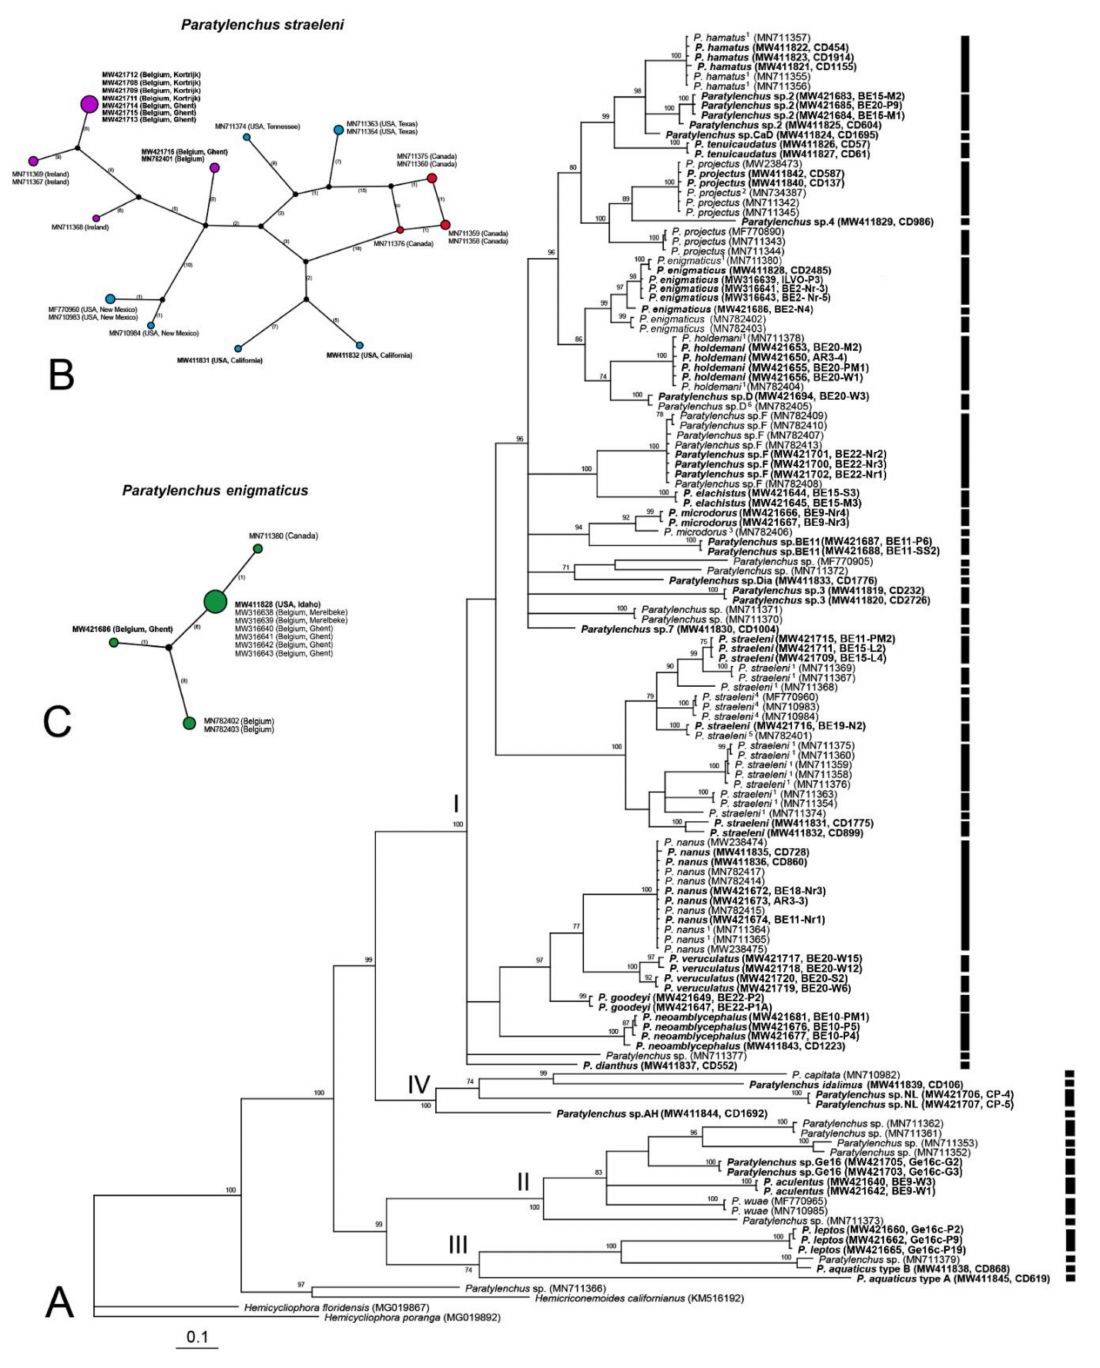
Figure 19. ( A ). Phylogenetic relationships within populations and species of Paratylenchus , as inferred from Bayesian analysis using the COI gene sequence dataset with the GTR + I + G model. Posterior probability more than 70% is given for appropriate clades. Newly obtained sequences are indicated in bold. 1 = originally identified as Paratylenchus sp., 2 = originally identified as P. nanus , 3 = identified as Paratylenchus sp.E, 4 = originally identified as Gracilacus sp., 5 = originally identified as Paratylenchus sp.8, 6 = originally identified as Paratylenchus sp.B; ( B ). Statistical parsimony network showing the phylogenetic relationships between COI haplotypes for P. straeleni ; ( C ). Statistical parsimony network showing the phylogenetic relationships between COI haplotypes for P . enigmaticus . Pies (circles) represent the sequences with the same haplotype and their size is proportional to the number of these sequences in the samples. Numbers of nucleotide differences between the sequences are indicated on lines connecting the pies. Small black circles represent missing haplotypes. Bars represent species boundaries estimated by both GMYC and bPTP methods (identical